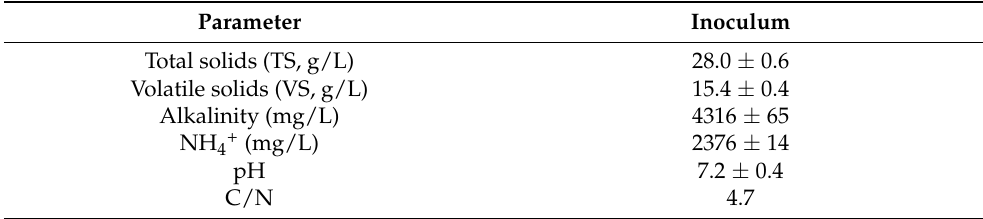
Table 1. Inoculum chemical